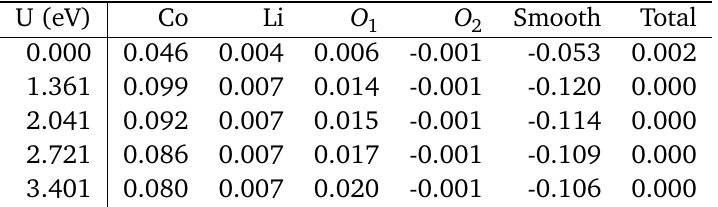
Figure 12: (Top left) Intersecting surface bands in TB model, (Top right) band struc- ture of surface states and Density of States (DOS) contribution from each band (black on Li side, and blue on CoO side) Surface states have a 2D dispersion corresponding 2 = 0.1 to a triangular lattice with nearest neighbor hopping parameters given by t x y CoO 2 = − 0.3 in arbitrary units with an on-site offset of δ = 0.9 (in units of and t x y Li + t x y ) ), (Bottom left) Surface charge per unit cell area as function of Γ / 6 = ( t x y CoO 2 Li on-site parameter δ ; (Bottom right) Ratio of charge on Li to charge on CoO surface 2 layers from numerical TB and analytic equation Eq.(6) derived in the main text. In the limit of δ = 0, this ratio approaches 1. Table 3: Magnetic moment in LiCoO monolayer in LSDA + 2